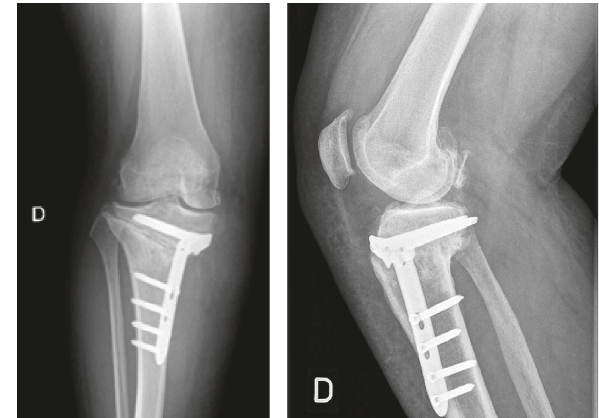
Figure 8: July 2013, 3 years after revision, postoperative X-rays showing increasing signs of